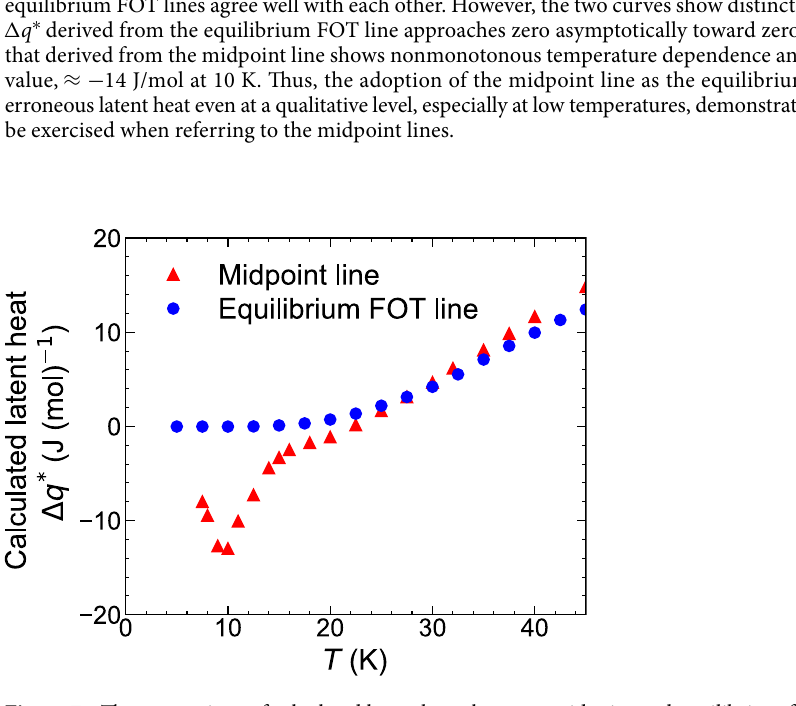
Figure 7. The comparison of calculated latent heats between midpoint and equilibrium first-order-transition lines. Temperature dependences of the calculated latent heats based on the midpoint line (red triangles) and the equilibrium FOT line (blue